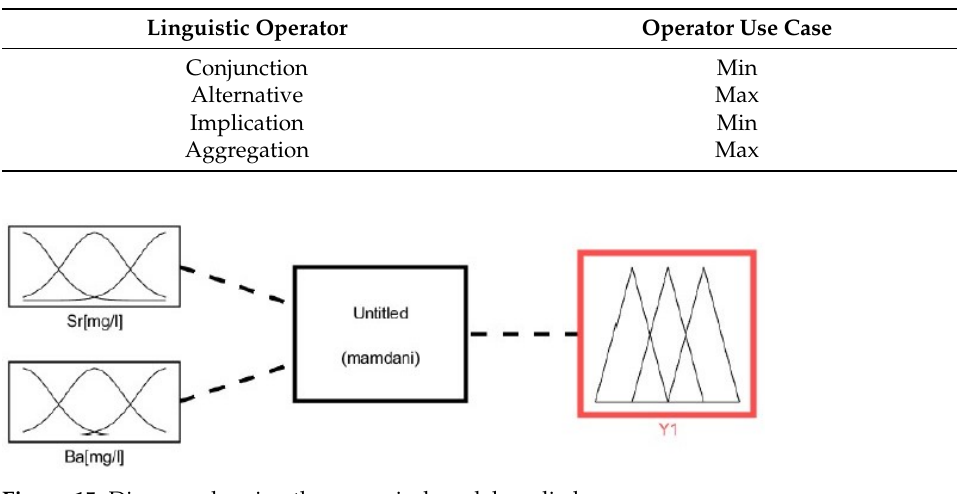
Figure 15. Diagram showing the numerical model applied.